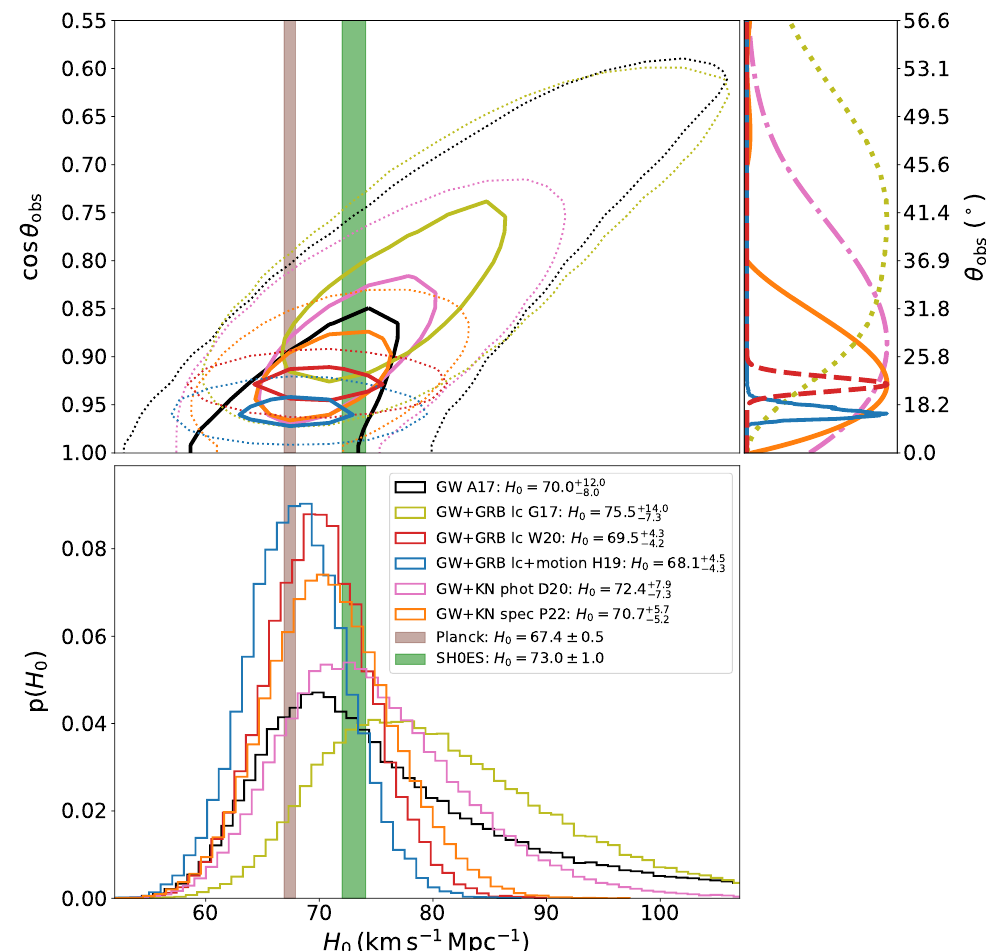
Figure 2. Improved constraints on H 0 from the BNS merger GW170817 through combination of GW and EM data. (Top-right) Posterior distributions on the observer viewing-angle from model fitting of the associated short GRB and KN. Constraints from GRB170817A are shown for model fits with (cyan [12]) or without (light green [11]; red [13]) information from the jet superluminal motion [95,96]. Constraints from the KN AT2017gfo are shown for model fits of broad-band photometry (pink [14]) and spectroscopy (orange [17]). The color scheme is the same in the remaining two panels. (Top-left) Same as in Figure 1 but adding improvements to the 2D posterior density contours when the viewing- angle constraints from GRB and KN fitting are used as priors for the inclination in the GW analysis. (Bottom) Marginalized 1D posterior density distributions for H 0 when using the original standard siren approach (black, same as in Figure 1) and when adding constraints on the viewing-angle from EM probes. The inferred H 0 values are reported in the